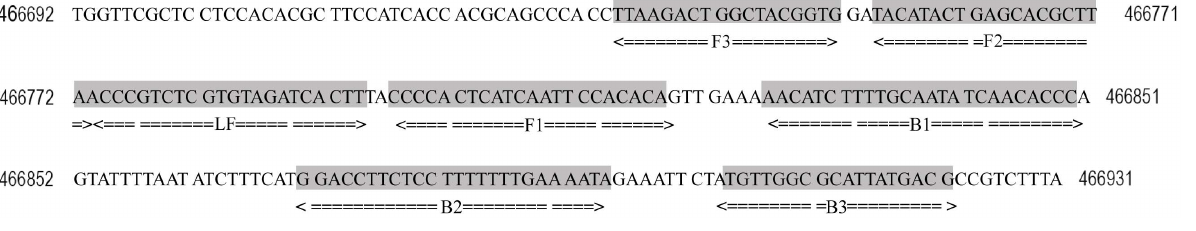
Figure 1. Names and binding sites of primers for Q fever LAMP. The sequences and positions of the set of primers (gray background) against repetitive IS1111a of htpAB gene of C. burnetii RSA 493 (AE016828.2).